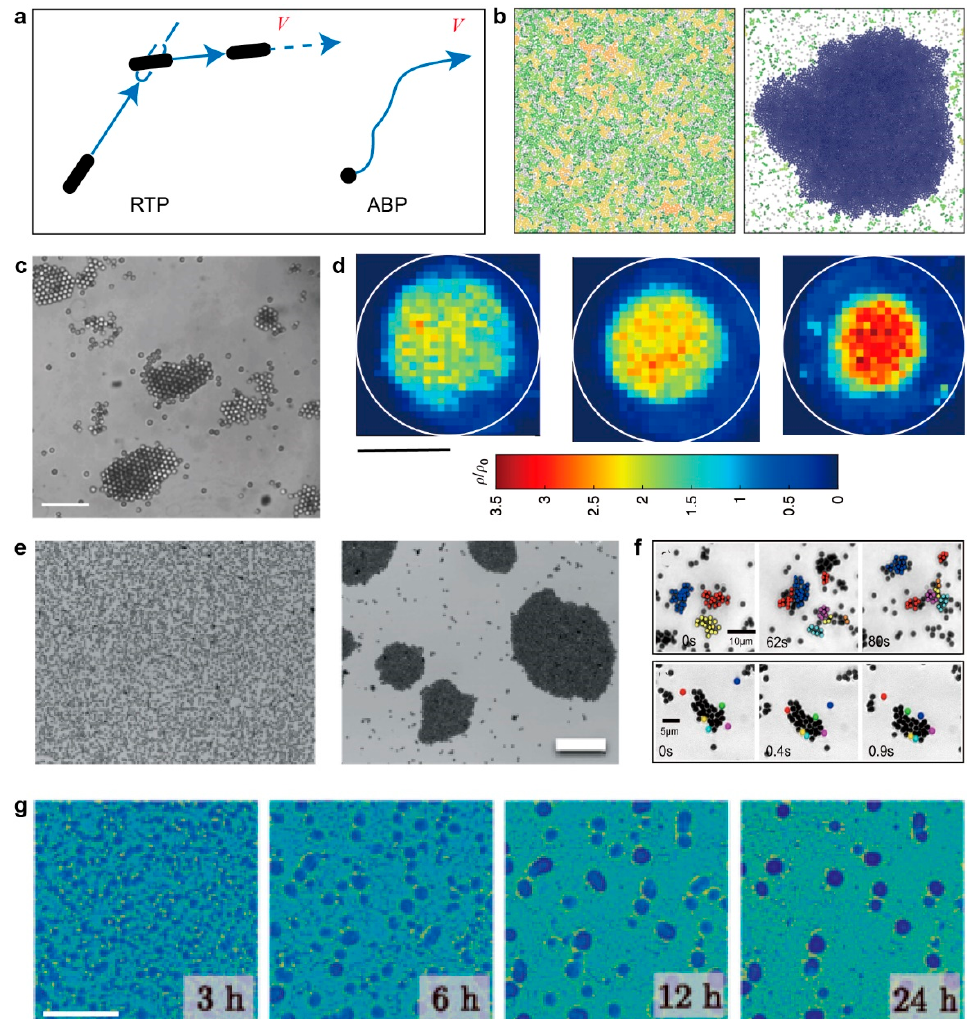
Figure 4. Physical model, simulation, and experiments related to MIPS. ( a ) Schematic of run-and- tumble particle (RTP) and active Brownian particle (ABP). ( b ) Separated phase of solid-like and gas phases without alignment; the packing fraction is 0.7. Reproduced with permission from [70]. ( c ) Phase separation of laser-activated colloidal particles into a few big clusters and a dilute phase. The scale bar is 20 𝜇𝑚 . Reproduced with permission from [71]. ( d ) Experimentally measured normalized particle density in steady states for increasing concentration threshold from left to right. The scale bar is 65 𝜇𝑚 . Reproduced with permission from [72]. ( e ) Aggregation process in a system of induced-charge electrophoretic self-propelled Janus colloids. The scale bar is 100 𝜇𝑚 . Reproduced with permission from [73]). ( f ) Dynamic clusters of self-propelled gold colloidal particles for surface fraction 𝜙 ≈ 5 % and 𝐶 (cid:3009) (cid:3118) (cid:3016) (cid:3118) = 0.1%. Reproduced with permission from [74]. ( g ) Microscopy image of M. xanthus cells undergoing phase separation. The scale bar is 0.5 mm. Reproduced with permission from